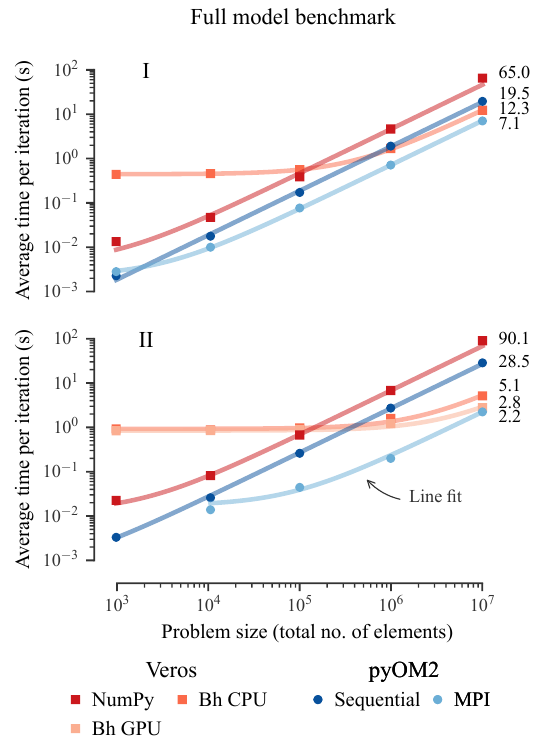
Figure 2. Thanks to pyAMG’s AMG preconditioner, the Veros stream function solver is between 2 (24 CPUs, II) and 11 (4 CPUs, I) times faster than pyOM2’s parallel conjugate gradient solver for large problem